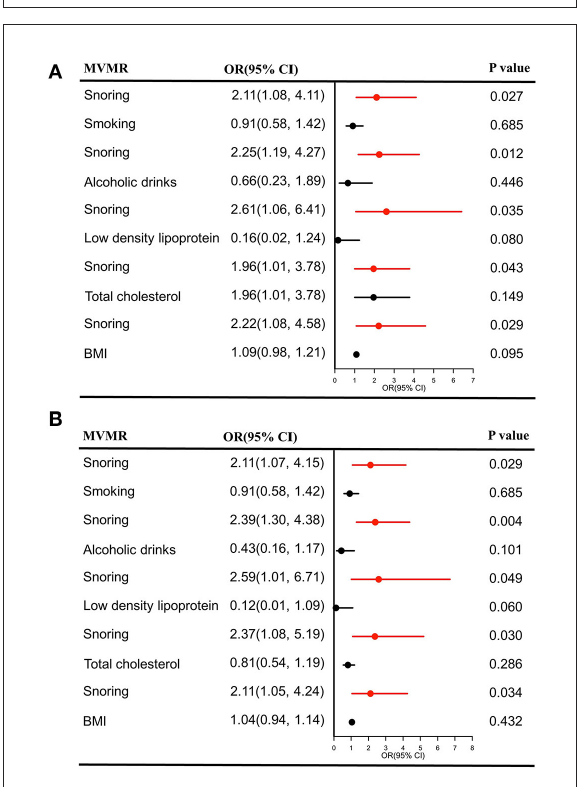
FIGURE4 Causal estimates of snoring on stroke (A) and IS (B) in MVMR. OR, odds ratio; CI, confidence interval; IS, Ishemic stroke; MVMR, multivariable Mendelian randomization; BMI, body mass